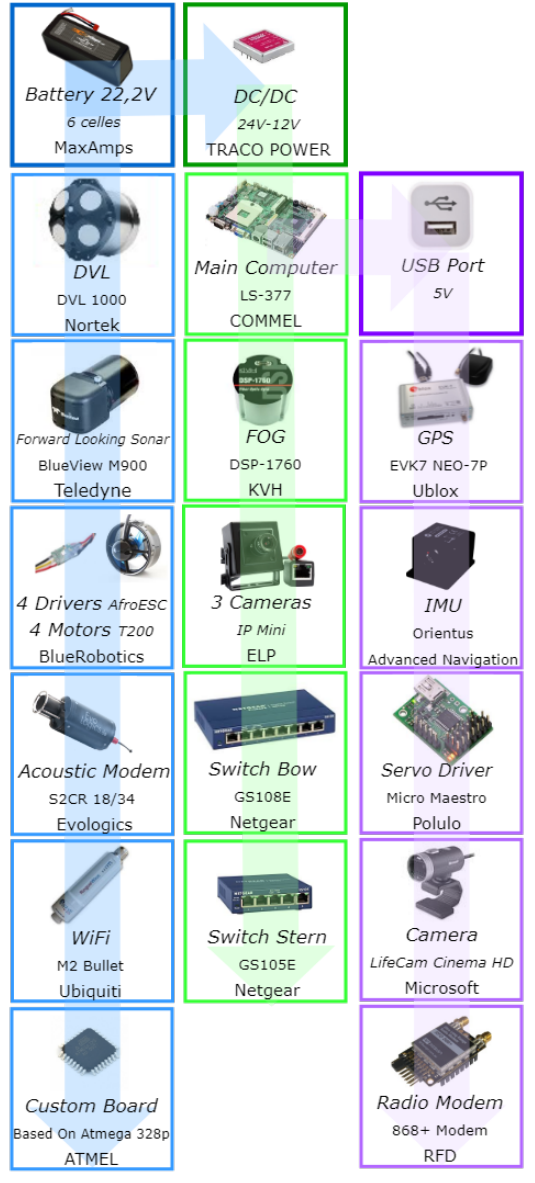
Figure 5. Power supply for the onboard